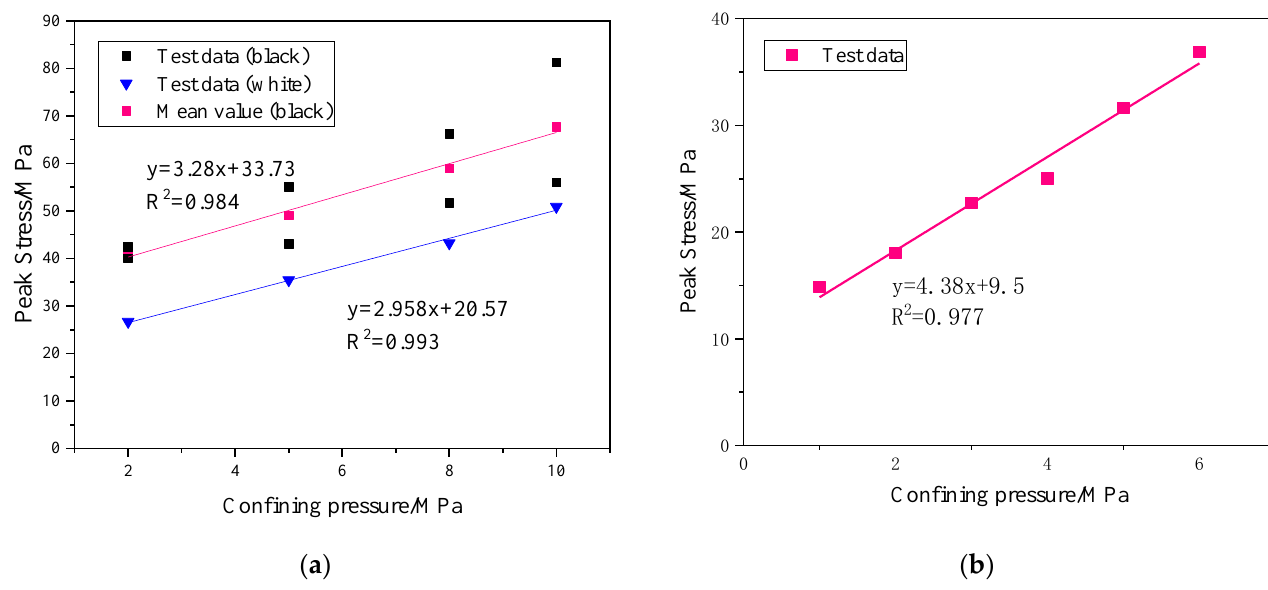
Figure 13. Relationship between peak stress and confining pressure of ( a ) small-scale specimens and ( b ) standard specimens [32]. Table 4. Cohesion and internal friction angle of two types of